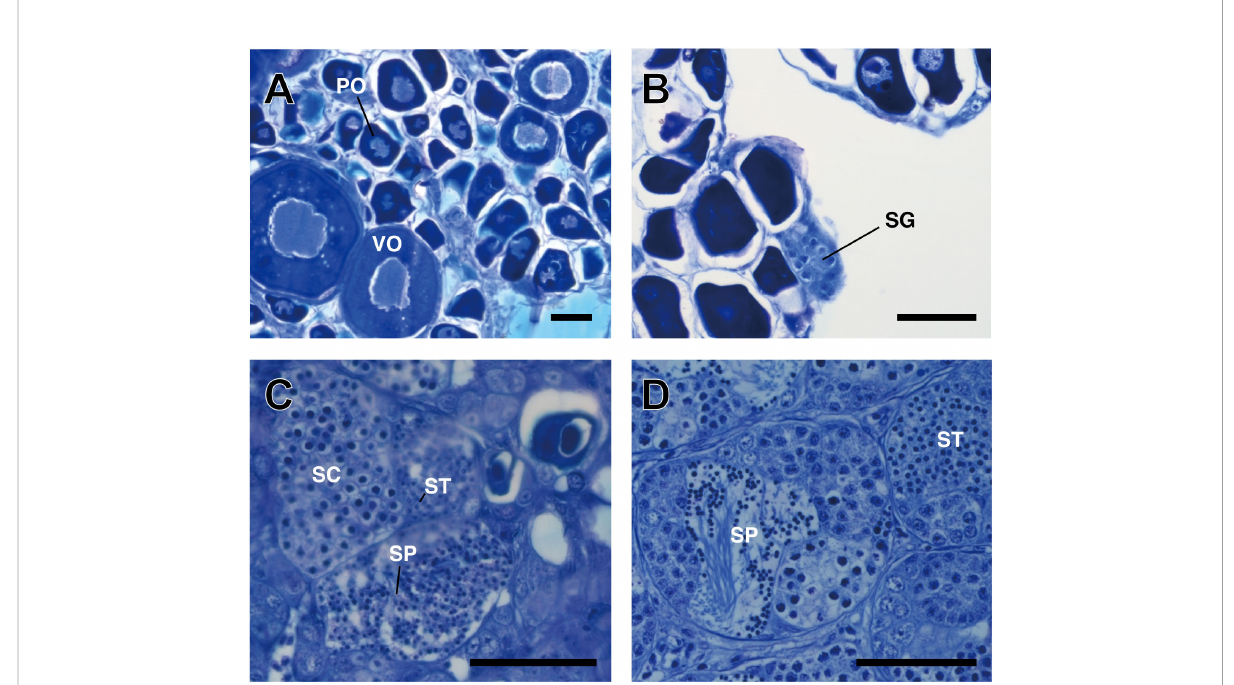
FIGURE 7 Modi fi cation in the gonadal histology of P. sieboldi after the induction of a sex change. (A) ovary; (B) stage 1 gonad after 7 days; (C) stage 2 gonad after 28 days. As a reference, the testis of TP male is shown (D) . Sex changes were induced during the pre-spawning season in fi sh placed in an 80 L tank. Black arrow; spermatogonia; white arrow; sperm. VO, vitellogenic oocyte, PO, perinuclear oocyte, SG, spermatogonia, SC spermatocytes, ST spermatids, SP sperm; bar length, 50